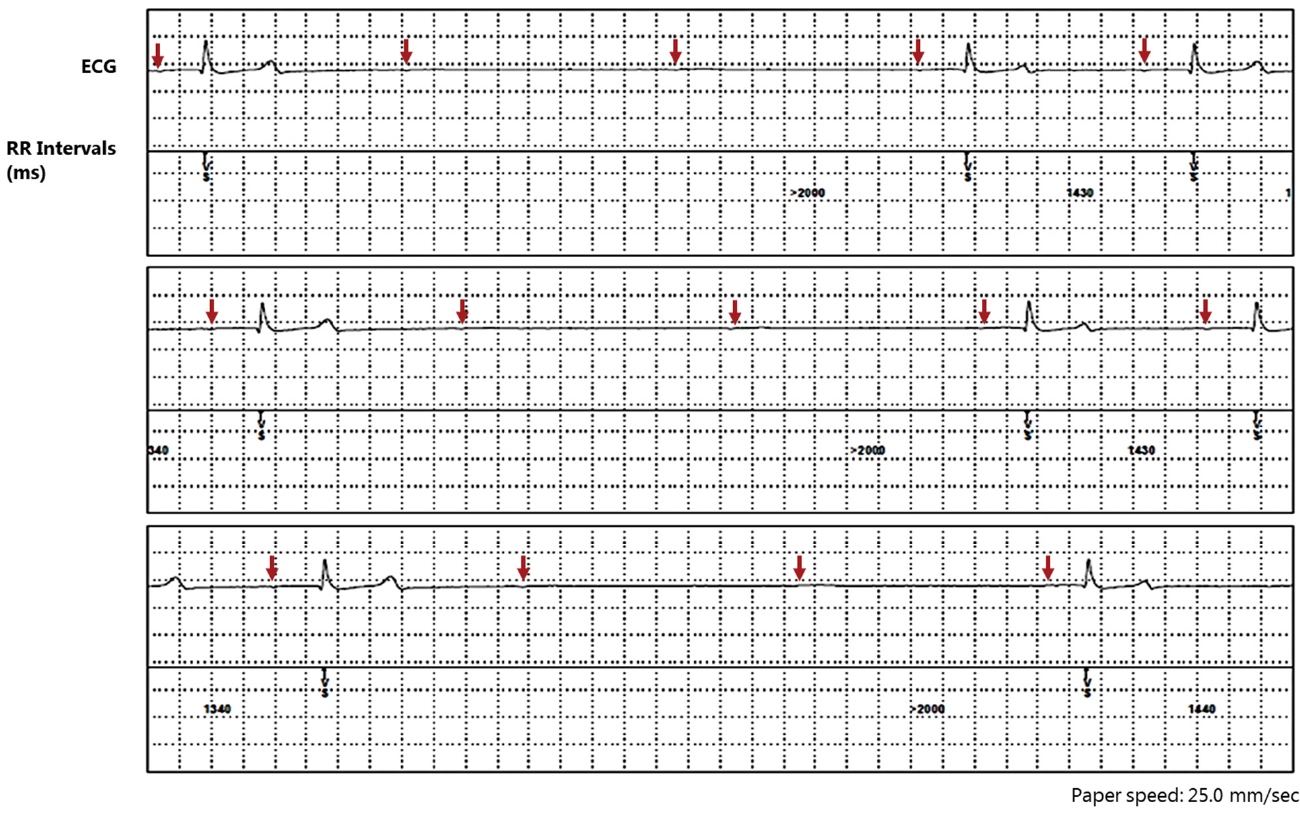
Figure 3. ECG from the implantable loop recorder. Several episodes were detected as pauses by the implantable loop recorder. All stored ECGs from the loop revealed several second-degree AV blocks. Often, two consecutive P waves were blocked. The amplitude of the P waves was very low and is, therefore, pointed out by arrows. The P waves are more readily visible directly in the programmer used to investigate with the loop recorder in order to extract data. Unfortunately, data were only printed on pdf files and no data were stored on the programmer; therefore, quality and amplitude are low. The above representative is a continuous recording sampled by the loop one afternoon in October 2019. VS: ventricular sensing.